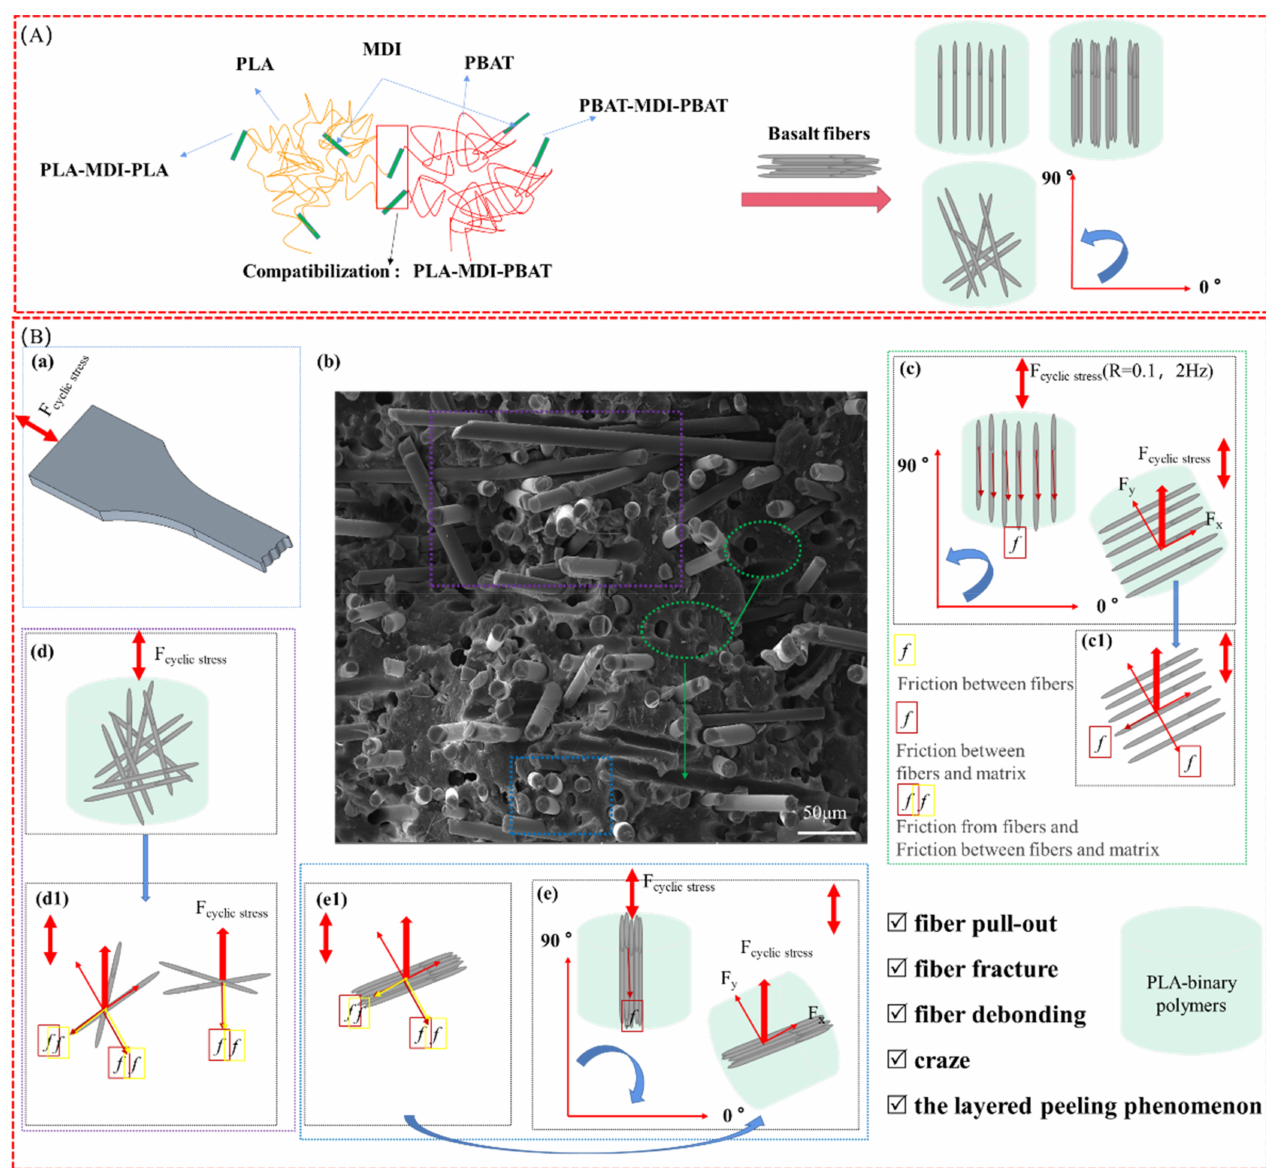
Figure 12. The polymerization schemes and fatigue failure mechanism of the polymers. ( A ) Polymer- ization schemes, ( B ) Fatigue failure mechanism: ( a ) scheme of the fatigue test; ( b ) fracture morphology of the PLA ternary polymers, with the phenomenon of fiber pull-out, fiber fracture, fiber debonding, craze and the layered peeling; ( c – e ) are the force status between BF and the matrix; c1 – e1 are the microscopic stress decomposition diagrams corresponding to ( c – e